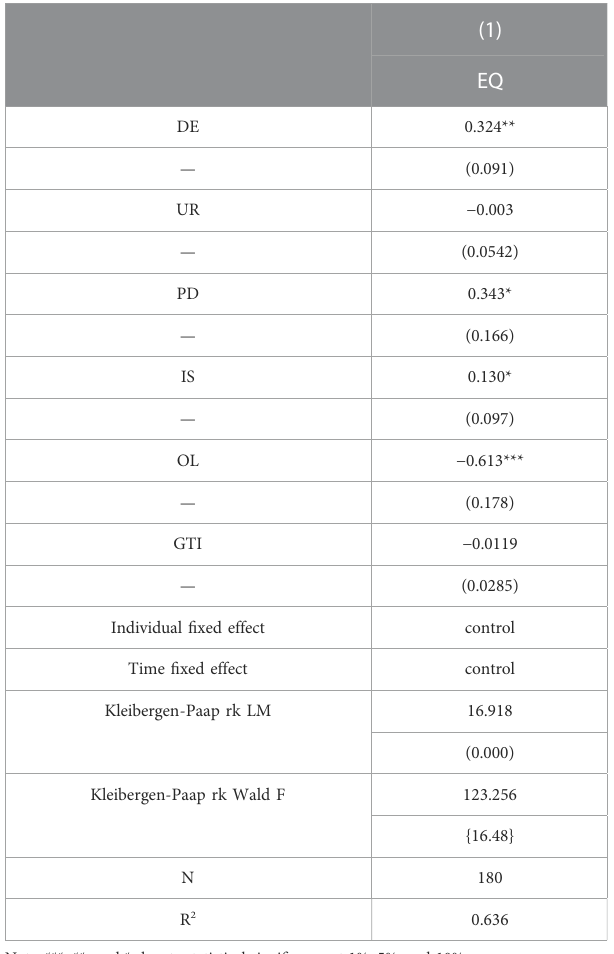
TABLE 6 Robustness test